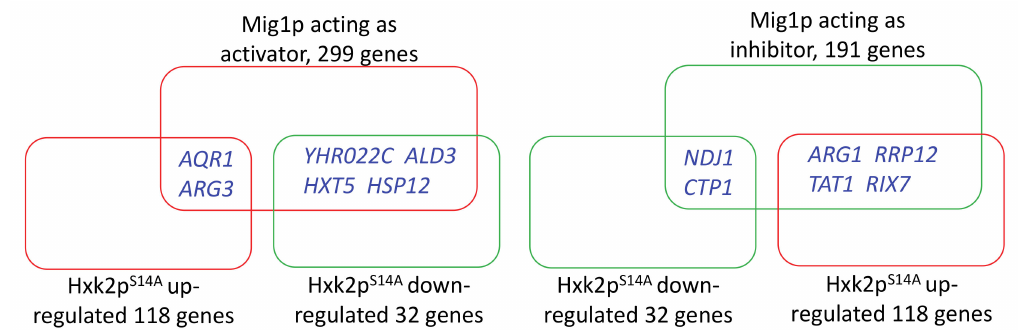
Figure 4. Comparison of the regulatory targets of Mig1p and Hxk2p S14A